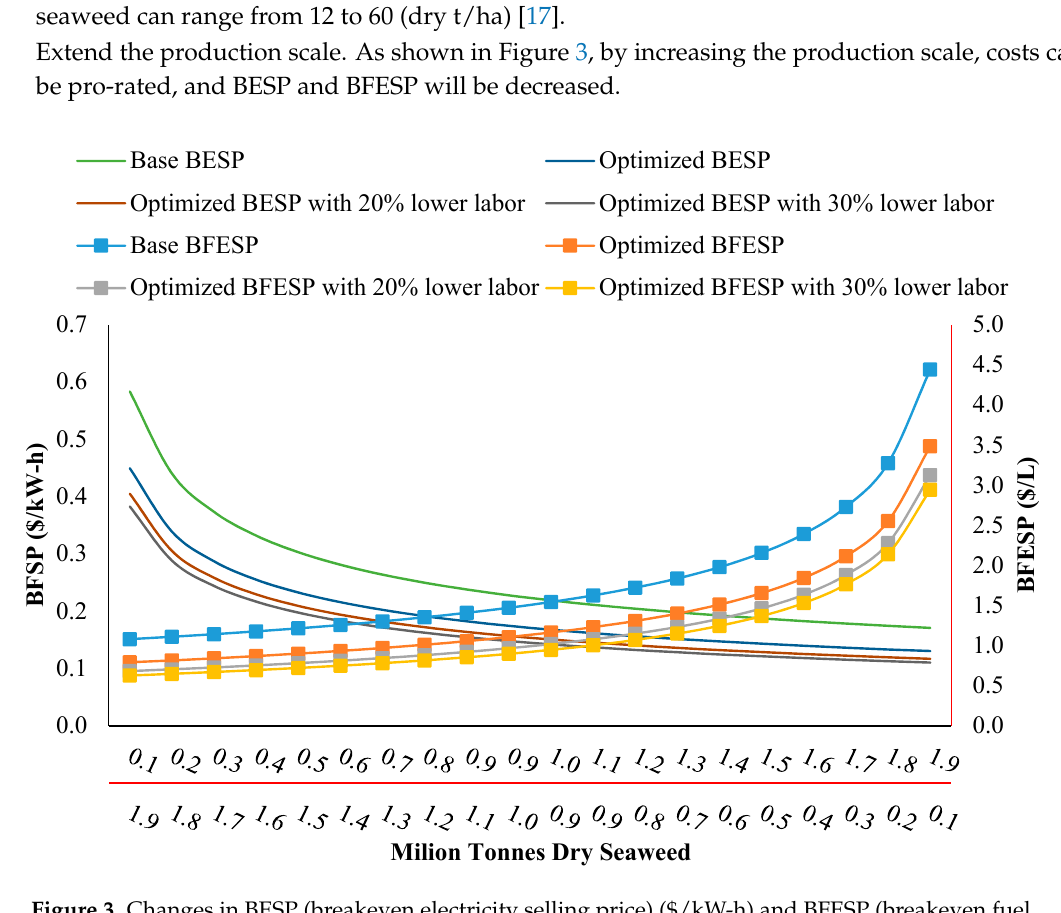
Figure 1. Changes in BESP ( breakeven electricity selling price ) ($/kW-h) and BFESP ( breakeven fuel ethanol selling price, $/L, red axis) as a function of scale of seaweed production (million tonnes dry seaweed per year).